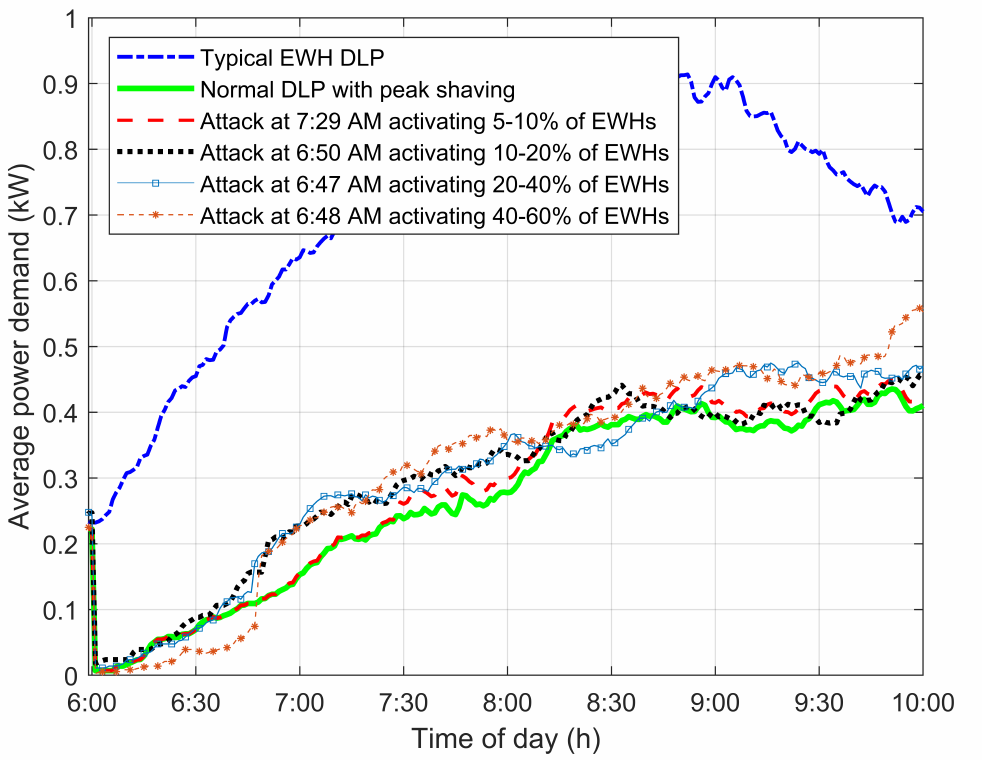
Figure 3. DLPs of 1000 EWHs in six cases. In the order they appear in the legend: (1) typical normal operation without peak shaving, (2) normal operation with peak shaving, and (3)–(6) peak shaving under LAAs launched at random times activating a subset of